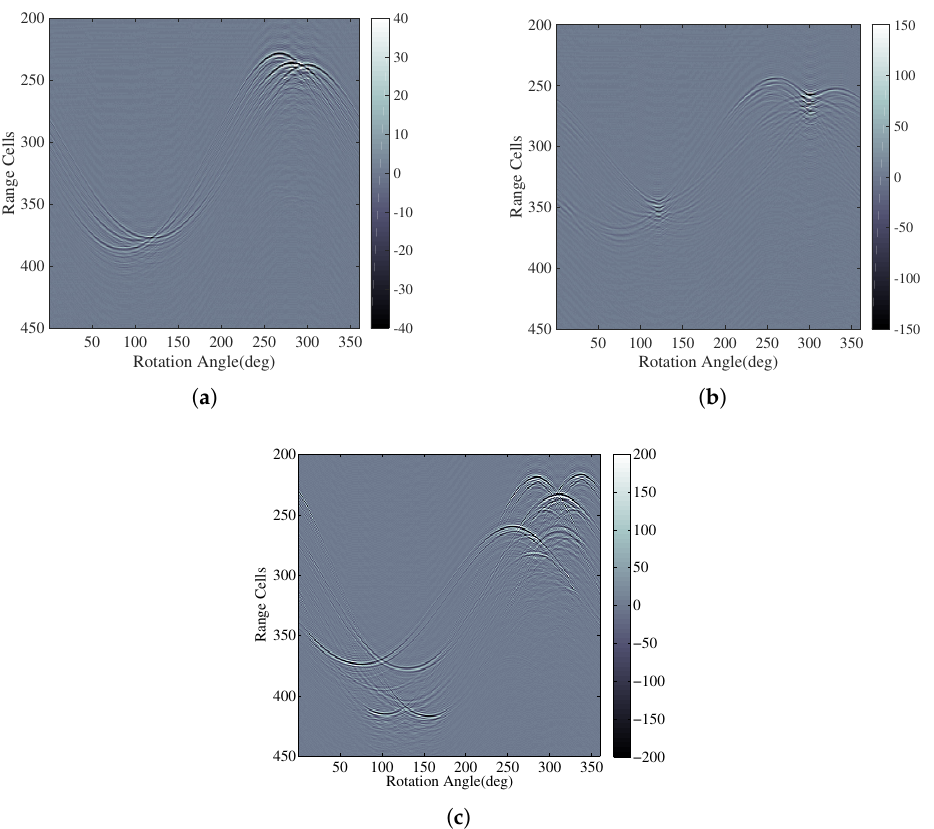
Figure 4. The data after upsampling contained only the real parts and negative quantities. The data angle step was 1 ◦ , and the range cell was 2.77 mm in length. The figures show the range from the 200th range cell to the 450th range cell, or from 415.5 to 1246.5 mm. The colormap ranges were from − 40 to 40 for the pins, from − 150 to 150 for the case, and from − 200 to 200 for the vase. ( a ) The three pins; ( b ) The pencil case with metallic pen; ( c ) The leather vase and cylinders.